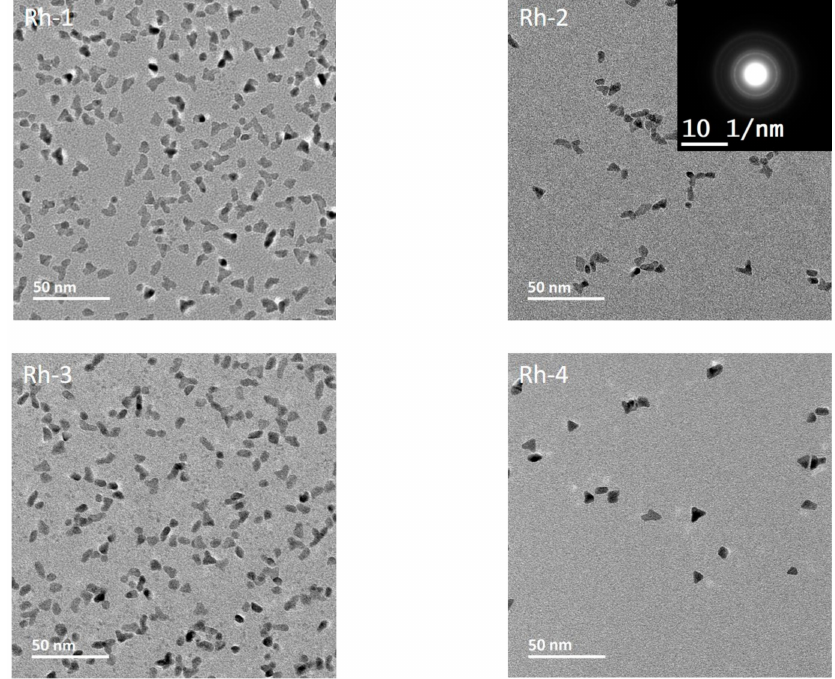
Figure 4. TEM micrographs of as-synthesized Rh NPs labeled with the name of respective samples. For the details of synthesis and labeling, see Table